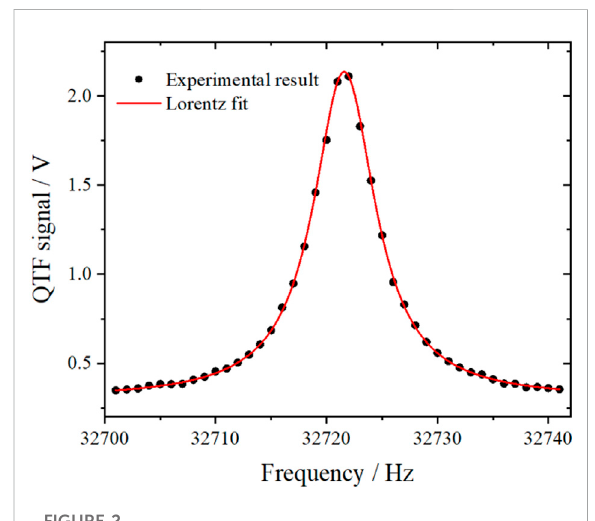
FIGURE 2 Frequency response curve of the QTF fi tted with the Lorentz pro fi le.